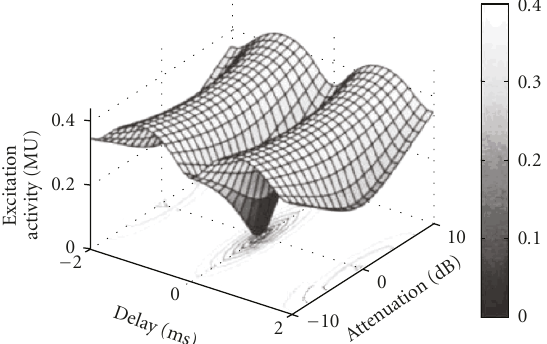
Figure 11: An example of auditory nerve excitaton surface with ITD = 0ms and ILD = 0dB, adapted from